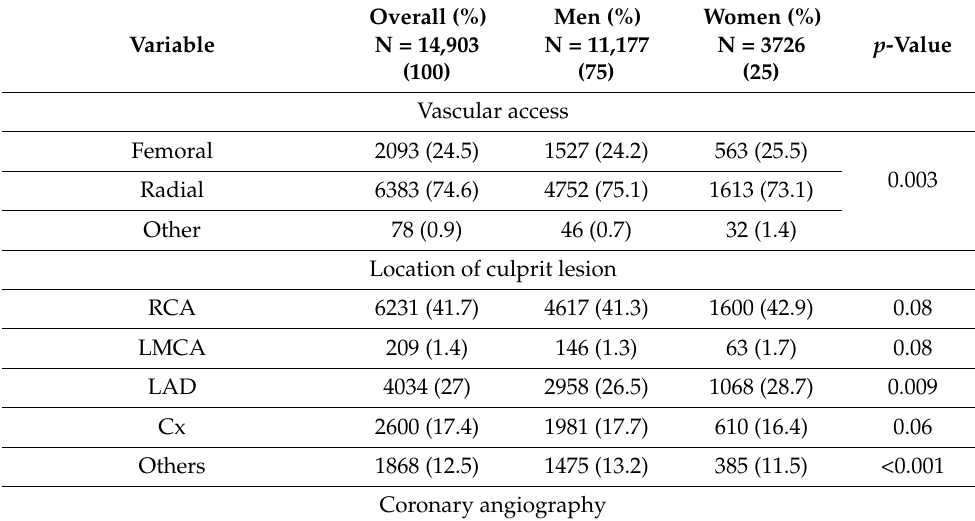
Table 2. Coronary angiography and procedural